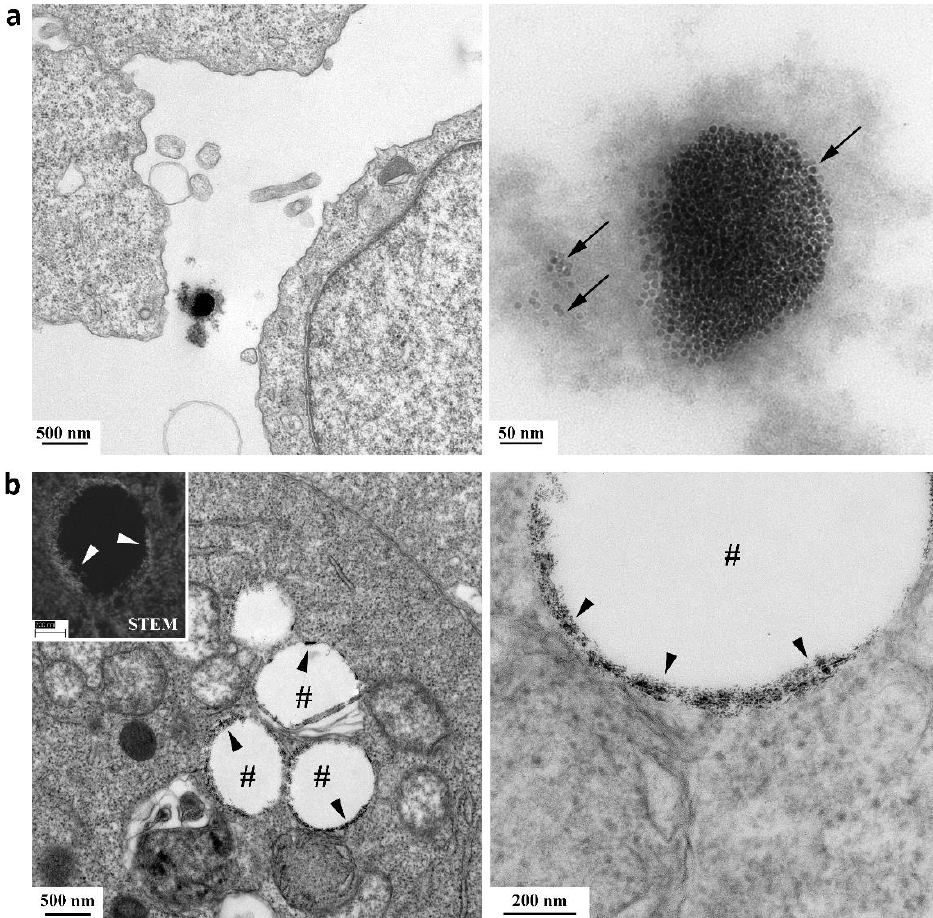
Figure 4. Ultrastructural analysis of Apt-Dend-NP inside MIA-PaCa-2 cells. ( a ) Metal aggregates found in the extracellular medium; ( b ) Dendrimer internalization by micropinocytosis mechanism. Arrows = SPIONs aggregate. Arrowheads = Apt-Dend. # = macropinosomes.